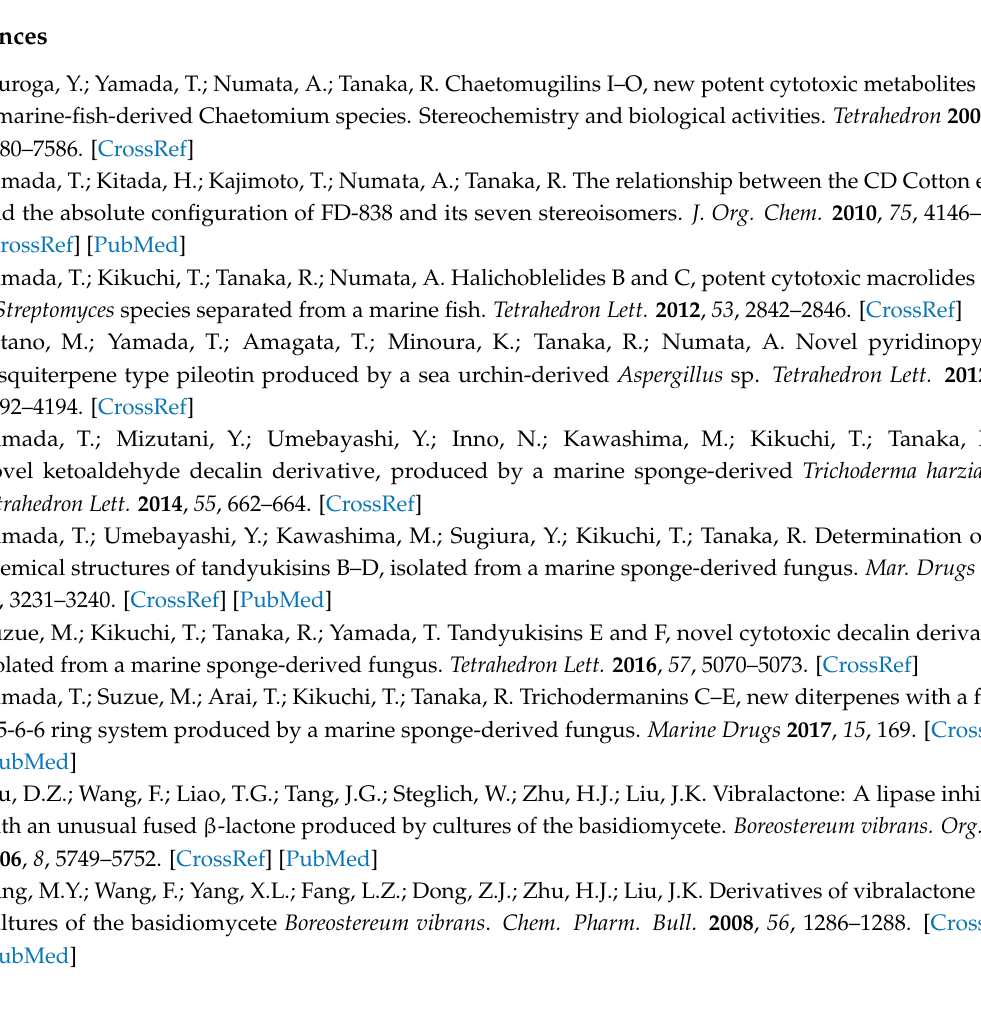
C NMR spectra of 1 in CDCl 3 , Figure S3: 1 H- 1 H COSY of 1 , Figure S4: NOESY of 1 , Figure S5: HMQC of 1 , Figure S6: HMBC of 1 , Figure S7: 1 H NMR spectrum of 2 in CDCl 3 , Figure S8: 13 C NMR spectrum of 2 in CDCl 3 , Figure S9: 1 H- 1 H COSY of 2 , Figure S10: NOESY of 2 , Figure S11: HMQC of 2 , Figure S12: HMBC of 2 , Figure S13: 1 H NMR spectrum of 3 in CDCl 13 C NMR spectrum of 3 in CDCl 1 H- 1 H COSY of 3 , 3 , Figure S14: 3 , Figure S15: Figure S16: NOESY of 3 , Figure S17: HMQC of 3 , Figure S18: HMBC of 3 , Figure S19: 1 H NMR spectrum of 4 in CDCl 3 , Figure S20: 13 C NMR spectrum of 4 in CDCl 3 , Figure S21: 1 H- 1 H COSY of 4 , Figure S22: NOESY of 4 , Figure S25: HMQC of 4 , Figure S24: HMBC of 4 , Figure S25: 1 H NMR spectra of 1a in CDCl 3 , Figure S26: 1 H NMR spectra of 1b in CDCl 3 , Figure S27: 1 H NMR spectra of methyl ester of 1 in CDCl 3